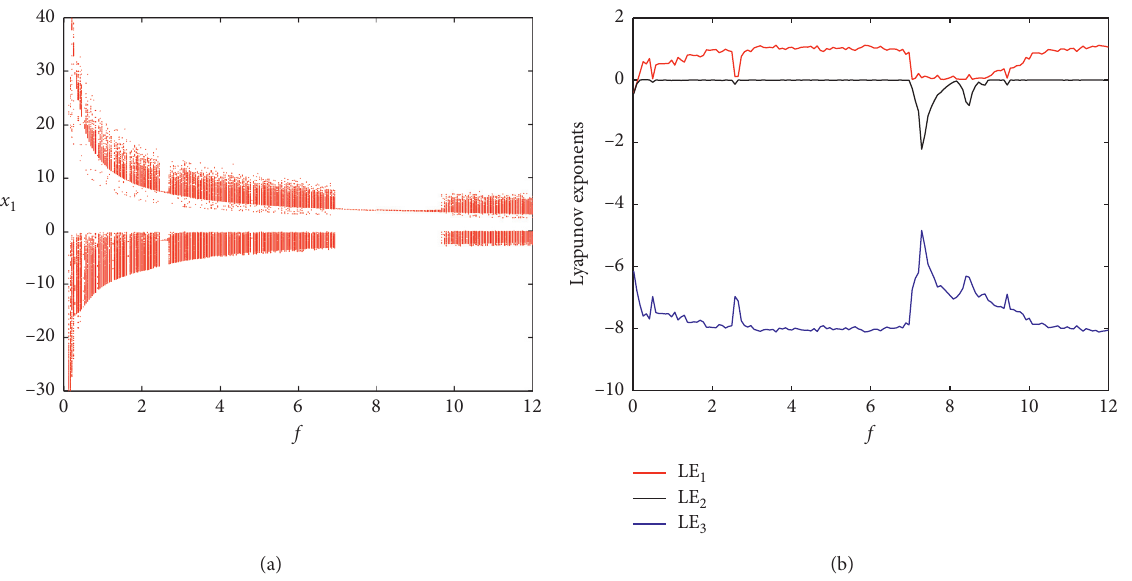
Figure 9: (a) Bifurcation diagram and (b) finite time Lyapunov exponent spectrum versus f